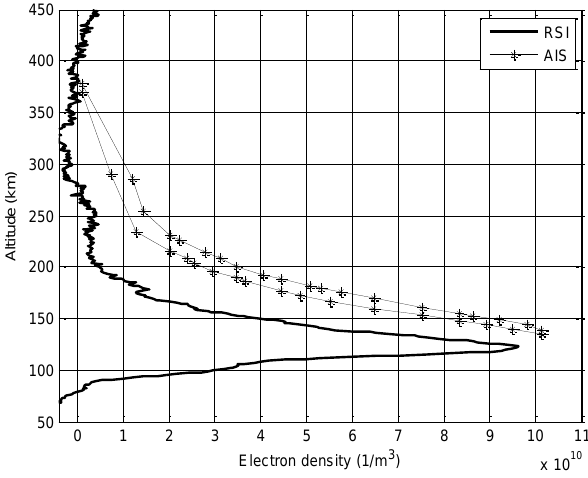
Fig. 5. Third Comparison between a profile obtained from Mars Express Radio Science (The same profile that in Fig. 3, Year: 2004, DOY: 180, Latitude: 10.2471 ◦ , SZA=74.6059 ◦ , Ls=53.21 ◦ , F 10 . 7 =85) (bold line) and two topside profiles obtained from MARSIS instrument with similar conditions of location, solar activ- ity and solar longitude but different conditions for solar zenith an- gle (Orbit: 3065, ionograms: 2–4, SZA=57–58 ◦ , Latitude=19.9– 18.9 ◦ , Ls=59.65 ◦ , F 10 . 7 =80) (light